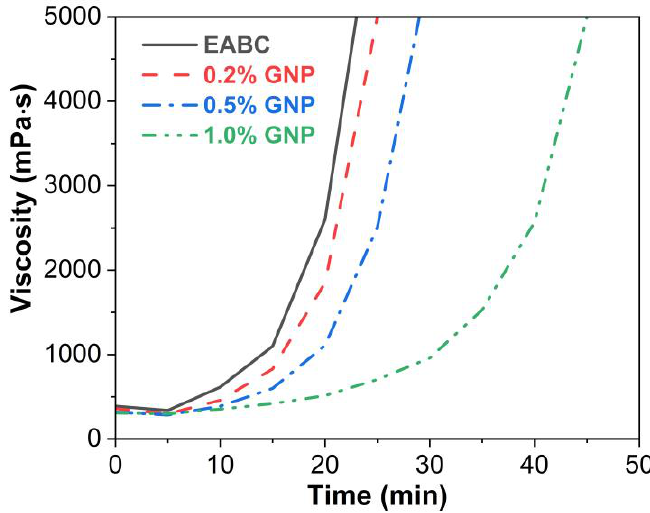
Figure 4. Rotational viscosity as a function of time of GNP-reinforced EABCs at 120 °C.